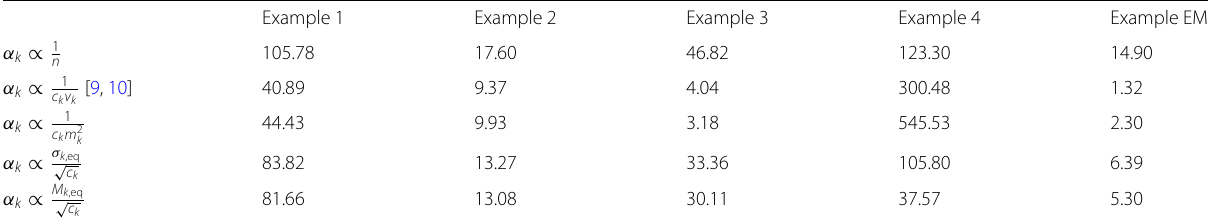
Table 5 Variance times cost (i.e., inefficiency, the smaller the better) for one-sample estimator for the four examples in Appendix C and the environment map example ( × 10 − 3 ) for balance heuristic using equal count of samples, for the count inversely proportional to the variances of independent estimators [9] and[10], and for the three new estimators defined in this paper Example 1 Example 2 Example 3 Example